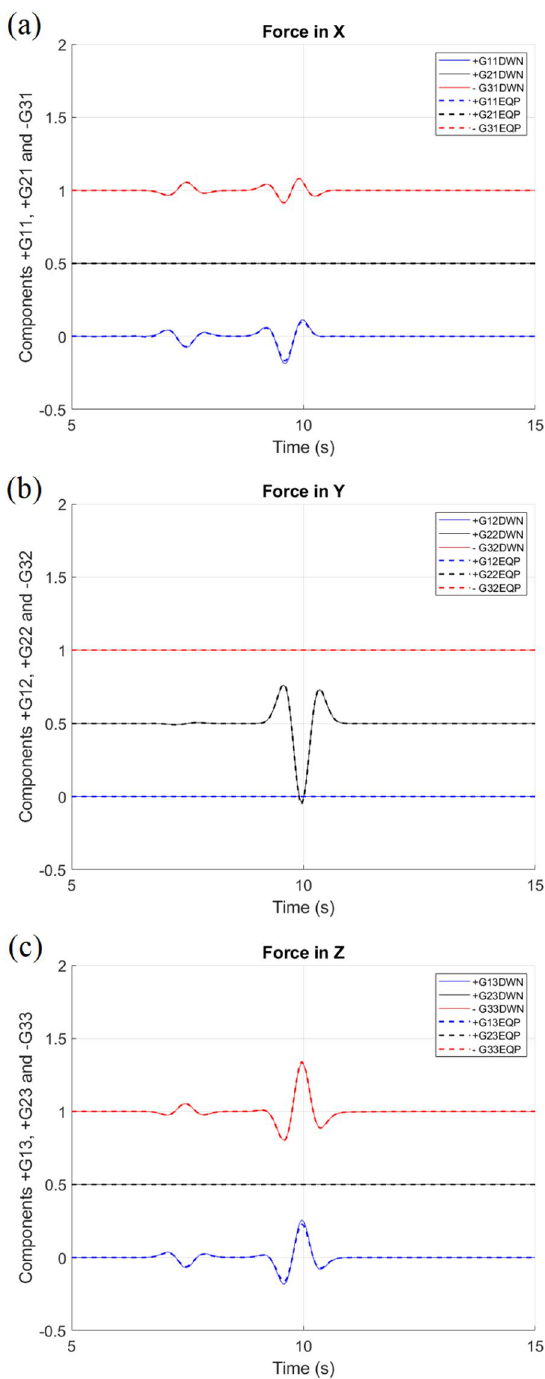
Fig. 7 Synthetic seismograms for the three forces at the origin 4 km, x 2 0 and depth x 3 3 km. Both and the receiver at x 1 = = = on the surface of a half‑space with Poisson ratio of 1/3. The chosen source was a Ricker pulse with “characteristic” period of 1 s and centered at 5 s. The maximum load value in absolute value is R 0 in GN ( 10 9 Newtons ) . The three panels correspond to force along x , y and z , respectively. Results from DWN are given with continuous lines as indicated in the legends. The synthetics using EQP are superimposed with dotted lines. The ordinates’ unit is meters after the common factor 2 π 10 4 R − 1 0 is applied